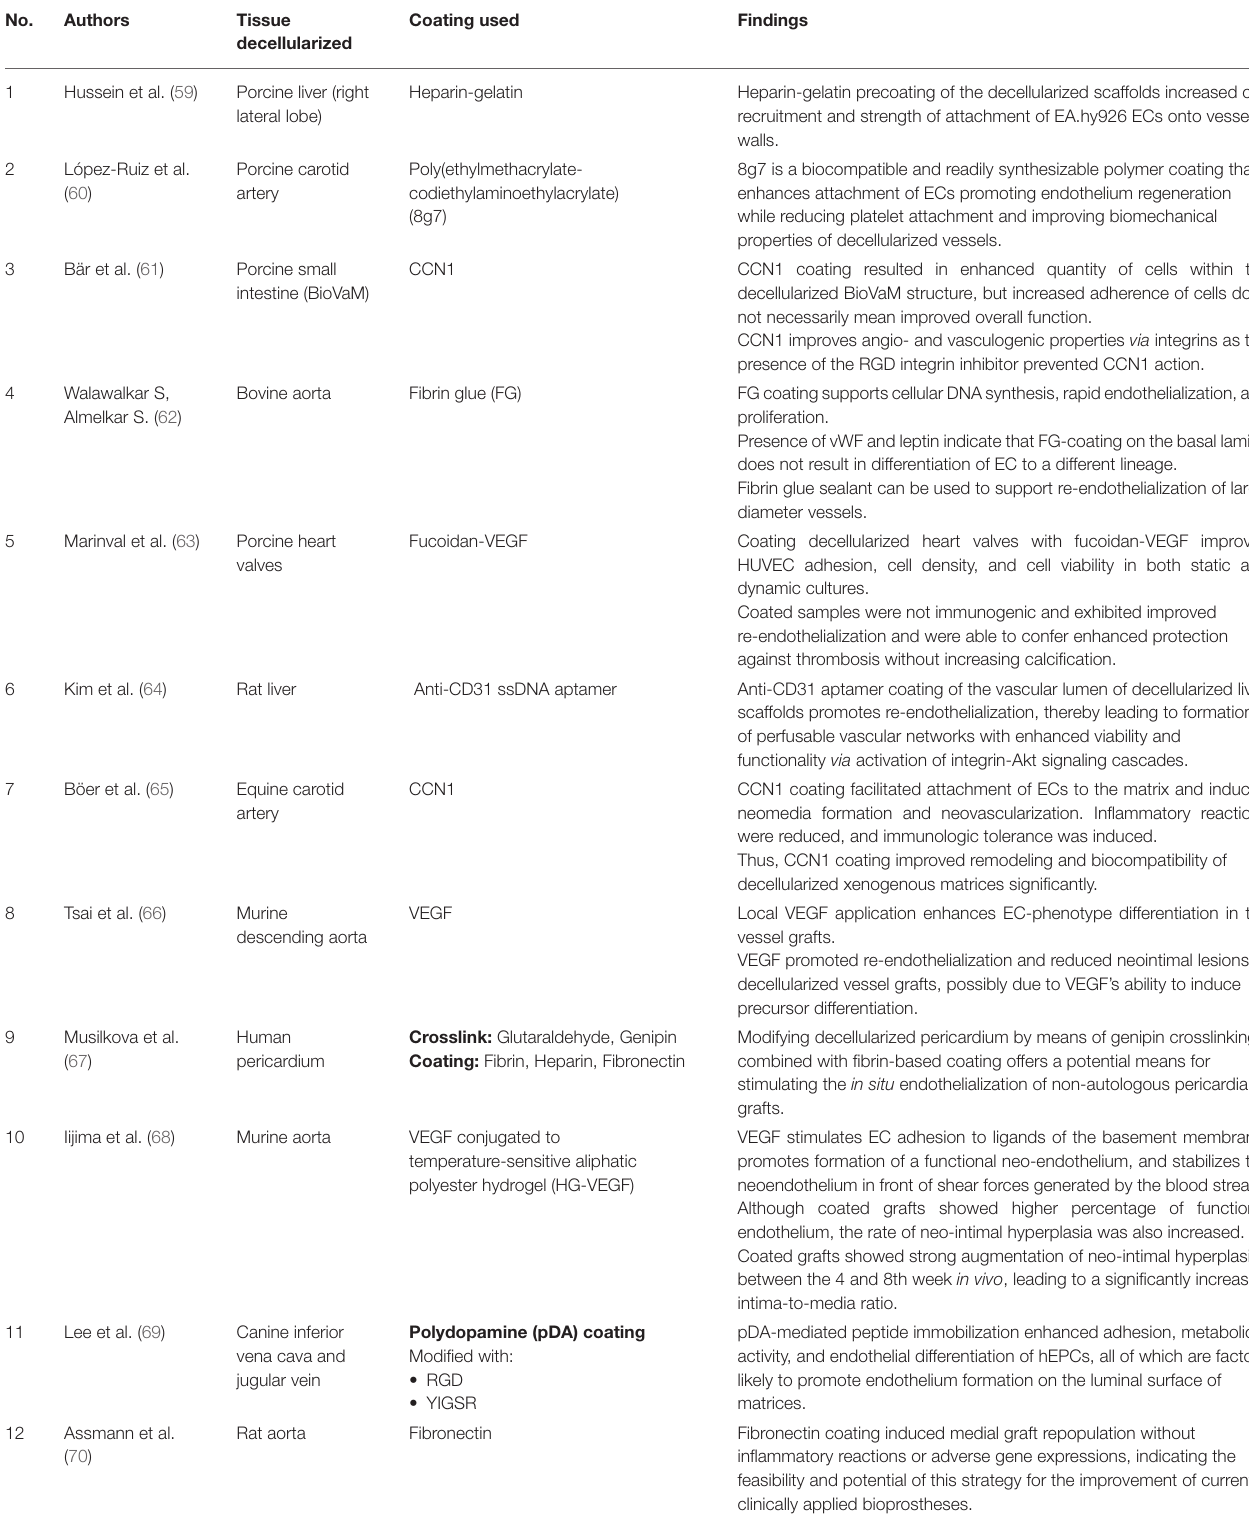
TABLE 1 | Summary of publications selected from electronic database